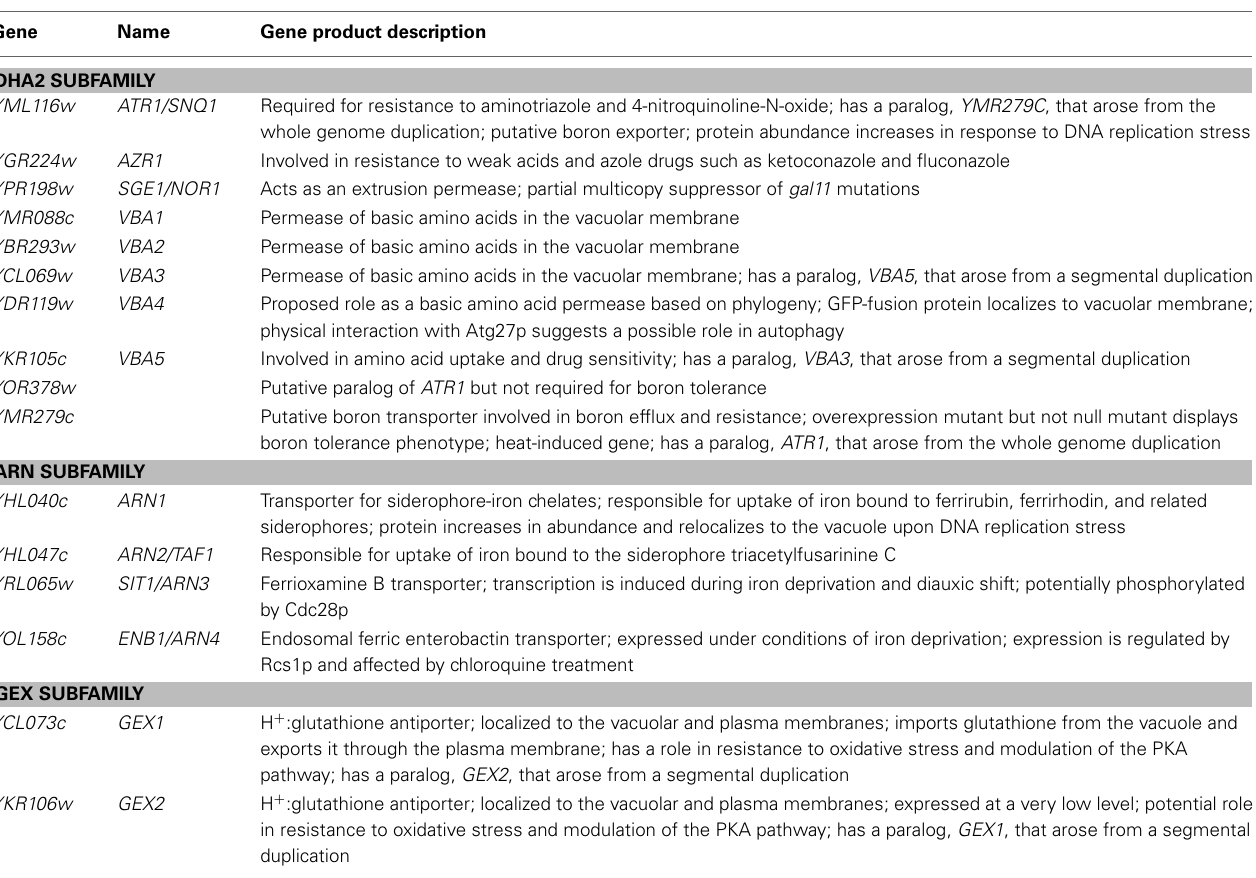
Table 2 | List of MDR/MXR-MFS transporters encoded in the genome of S. cerevisiae , belonging to the DAG family, gene product descriptions are based on the information listed for each gene in the Saccharomyces Genome Database.